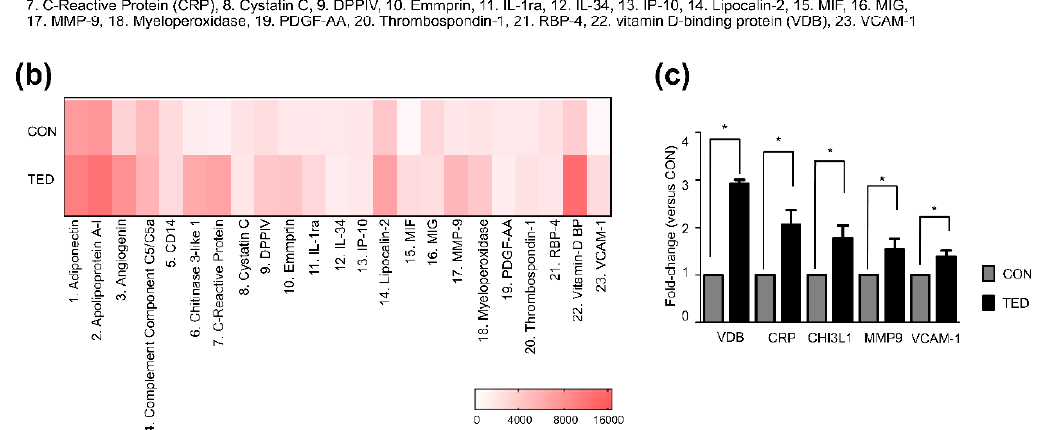
Figure 3. Analysis of exosome-contained proteins using the Proteome Profiler Human XL Cytokine Array. ( a ) Exosomes (100 µ g) were analyzed using the Proteome Profiler Human XL Cytokine Array Kit. Representative images of array membranes corresponding to three different patients with TED and three control subjects. The numbered spots indicate proteins that showed different signal intensities among the array membranes. Five proteins showing the greatest differences are indicated with black arrows in each panel. ( b ) Heatmap analysis showing signal-density measurements of the data shown in ( a ). Of 105 human proteins targeted by the kit, 23 proteins were detected. The spots in the line boxes were used for signal normalization. The scale bar represents unitless measurements that were determined based on the pixel density. ( c ) The data shown represent at least 1.4-fold changes in the protein levels (normalized to array reference marked with the line boxes) in patients with TED versus control subjects. The mean pixel-density value of the control subject was set to 1.0, and the fold-changes were calculated for each protein. The data shown are presented as the mean fold-change ± SD ( n = 3). Statistical differences were determined using a paired t-test (* p < 0.05). CON—control subject; SD—standard deviation; TED—patient with thyroid eye disease.